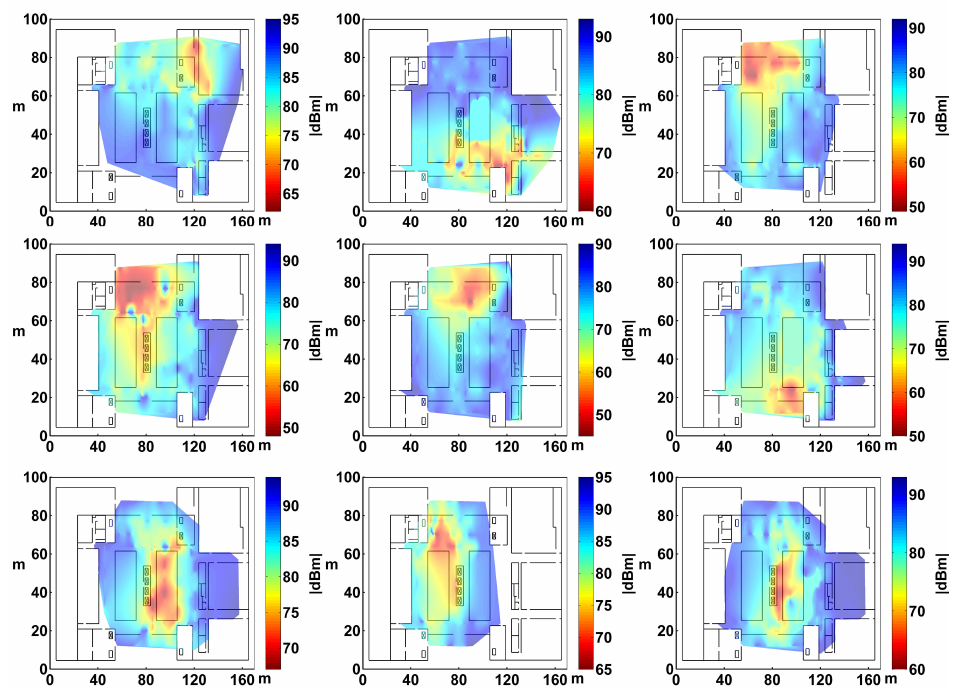
Figure 9. The visual results of radio